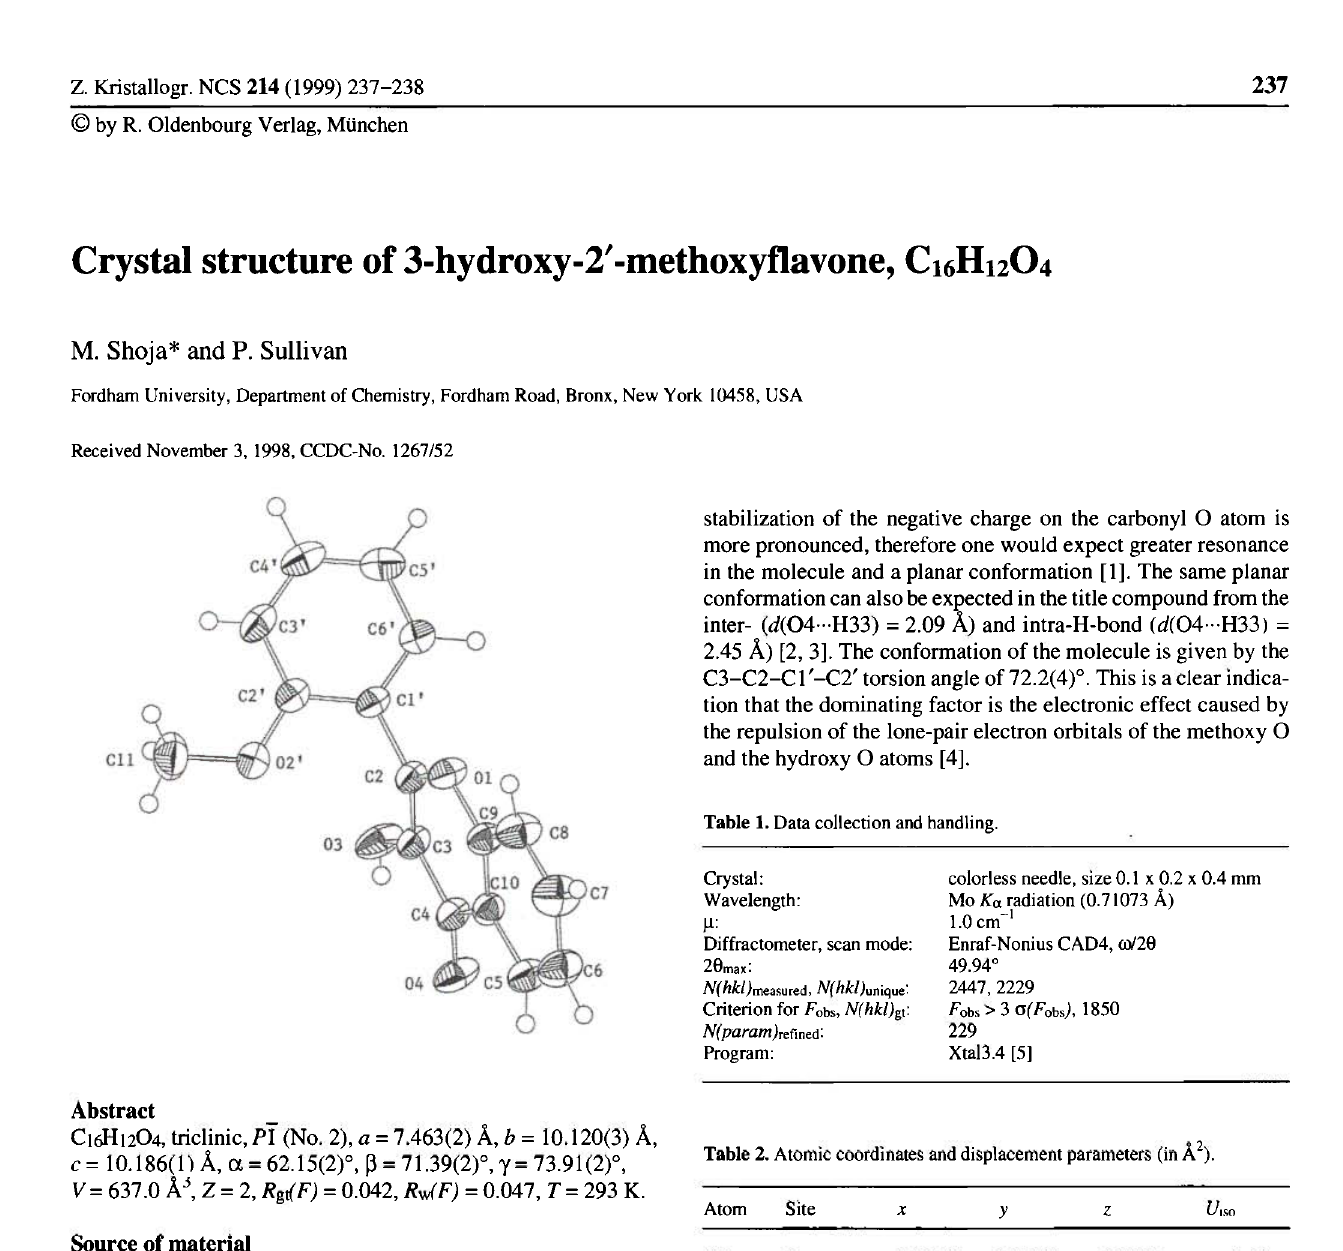
Table 2. Atomic coordinates and displacement parameters (in Ä 2